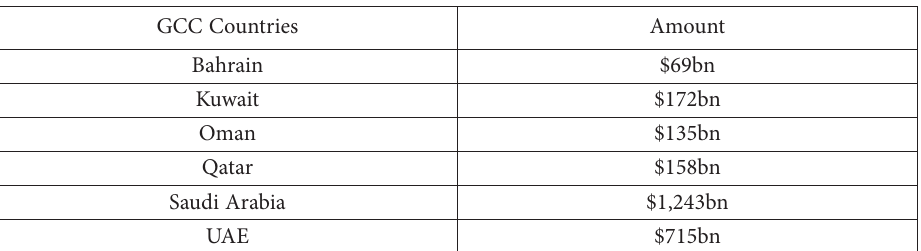
Table 8. Value of planned, unawarded GCC projects by country / $2tn project pipeline (source: MEED Projects, GCC Projects, Break bulk Middle East,